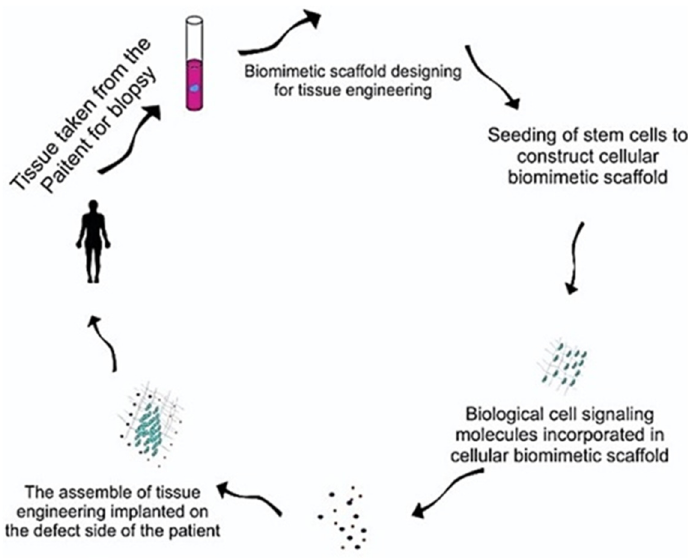
Figure 6. Diagrammatic representation of basic components and steps for the biomimetic tissue-engineering concept for dental tissue regeneration. (Reproduced from [416] with permission from the publisher)